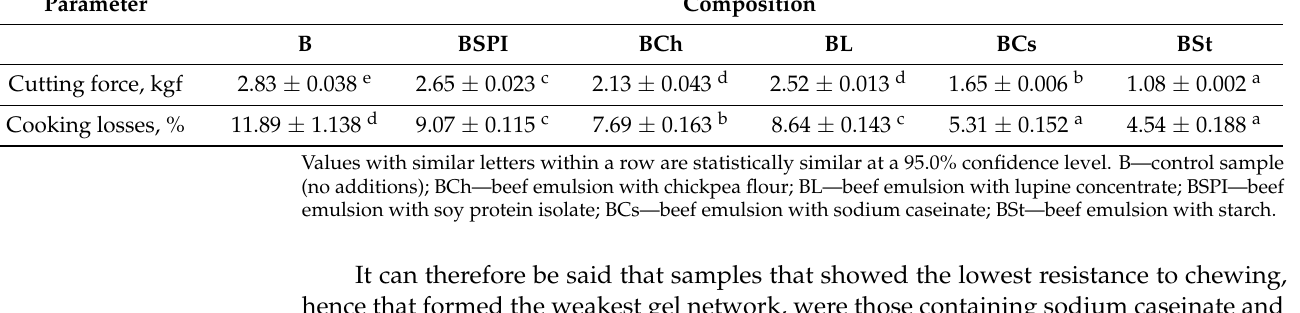
Table 3. Variation of some textural parameters depending on the nature of the additives used. Parameter